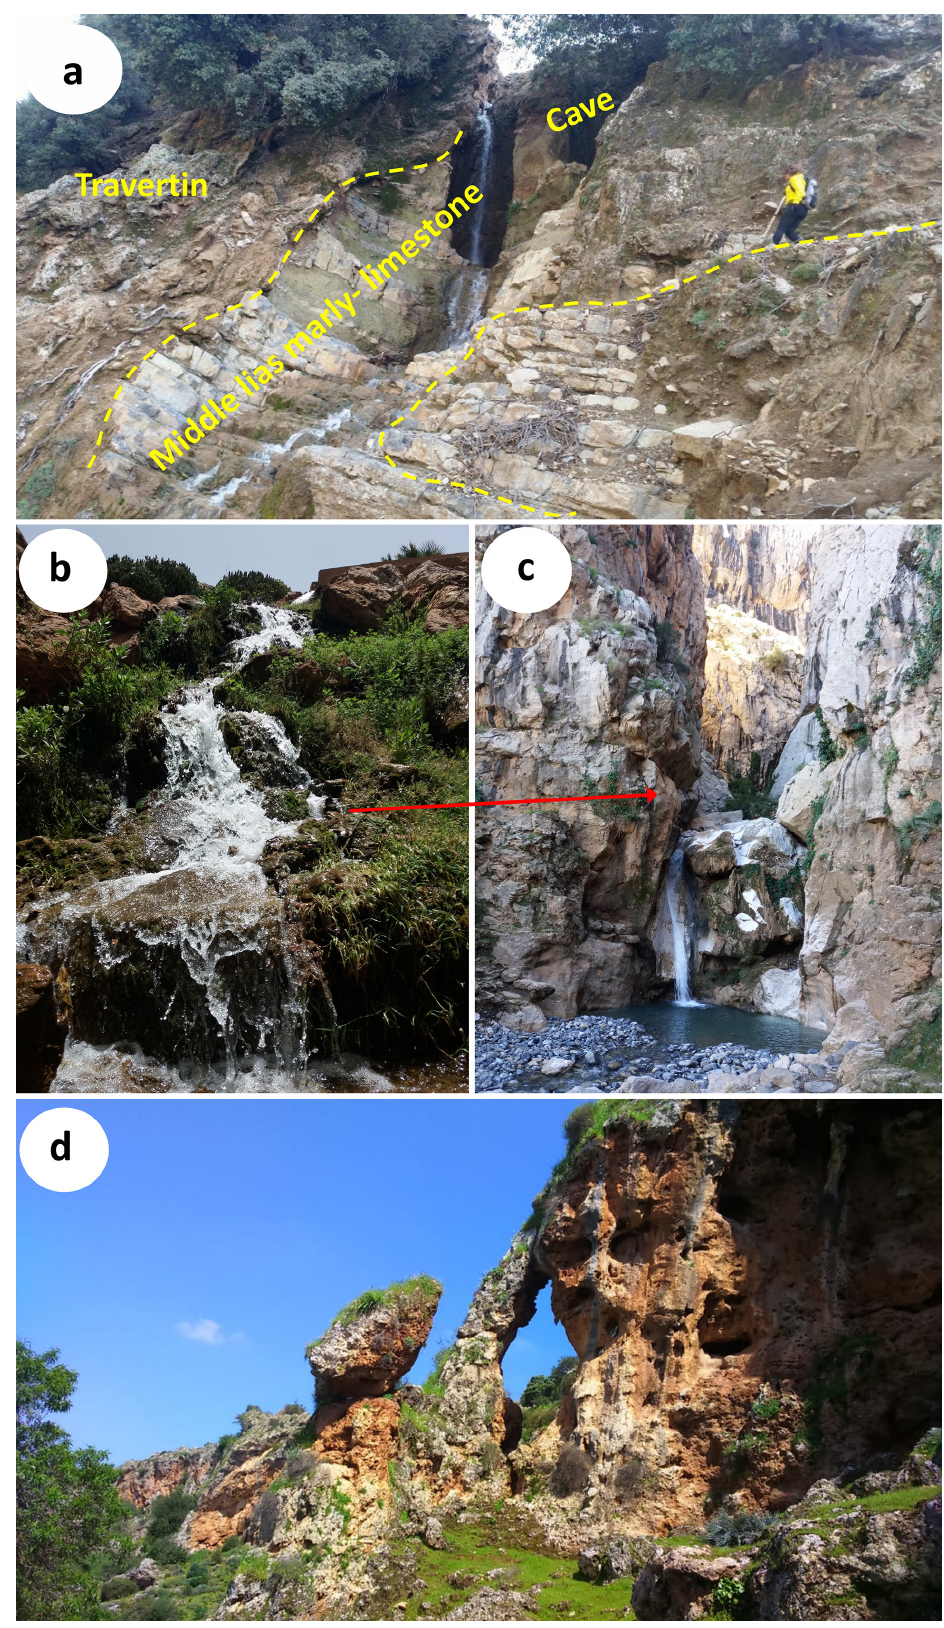
Fig. 7. The travertine, canyon and waterfalls of